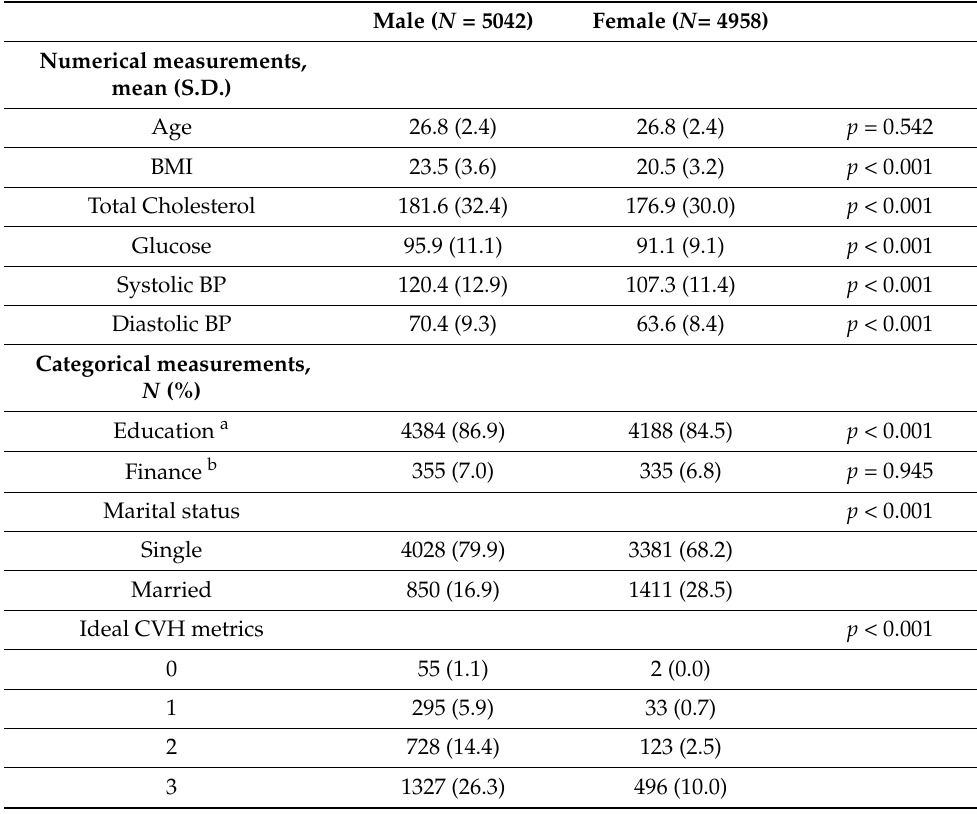
Table 1. Demographic data with ideal cardiovascular health metrics among the